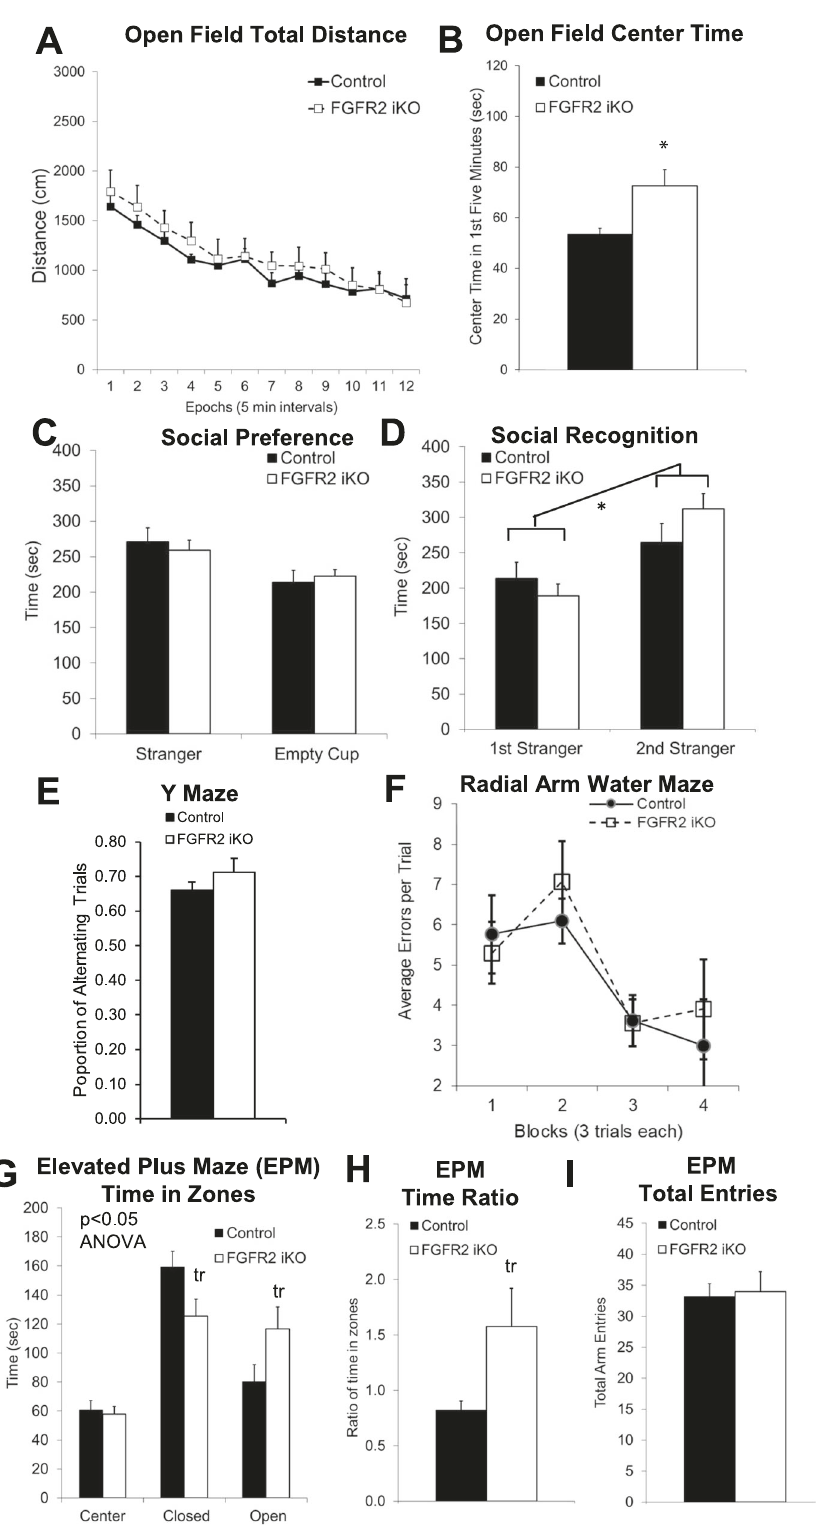
Fig. 3 Adult male mice lacking FGFR2 in adulthood driven by GFAP- CreER T2 (induced with adult tamoxifen injections P56-60) showed only reduced anxiety-like behavior. A No difference in distance traveled in the open fi eld. B Reduced anxiety-like behavior with open fi eld increased time in the center in FGFR2 iKO mice. C , D Three chamber social task showed no difference in social preference or social recognition. E No difference in working memory with Y maze spontaneous alternation. F No difference in working memory with errors on Radial Arm Water Maze training trials. G Reduced anxiety-like behavior with altered time spent in the closed and open arms of the EPM. H Reduced anxiety-like behavior with altered ratio of time in zones of the EPM. I No difference in locomotor activity with overall entries into all arms of the EPM. N = 7,10; * p < 0.05 two-tailed Student ’ s t-tests or ANOVA. Means and SEM shown.